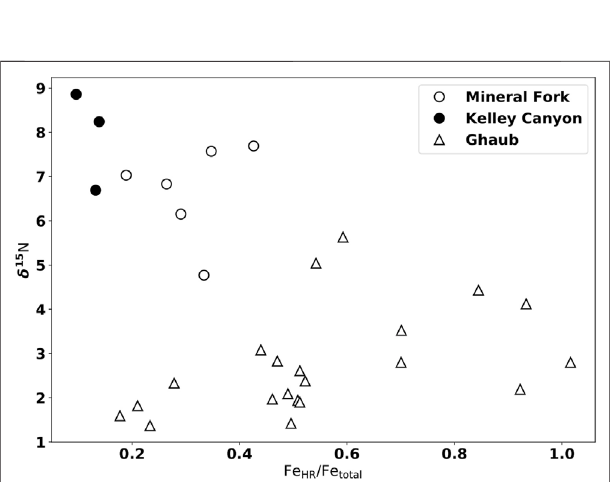
FIGURE 7 | Iron speciation data from the Mineral Fork Formation (open circles), Kelley Canyon Formation (closed circles), and the Ghaub Formation triangles). Mineral Fork samples with the highest δ 15 N values have the lowest Fe HR /Fe total , consistent with oxygenated waters and partial denitri fi cation. In contrast, samples from the Ghaub Formation show no clear correlation, consistent with an more anoxic water